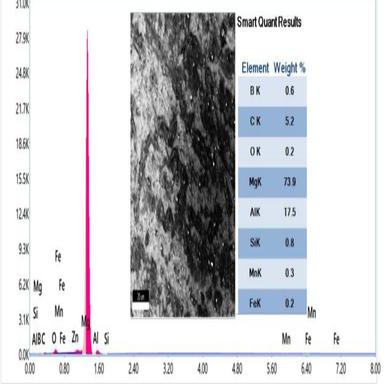
EDX Analysis (a) AZ31 alloy, b) AZ31-1.0 B4C, C) AZ31-2.0 B4C.